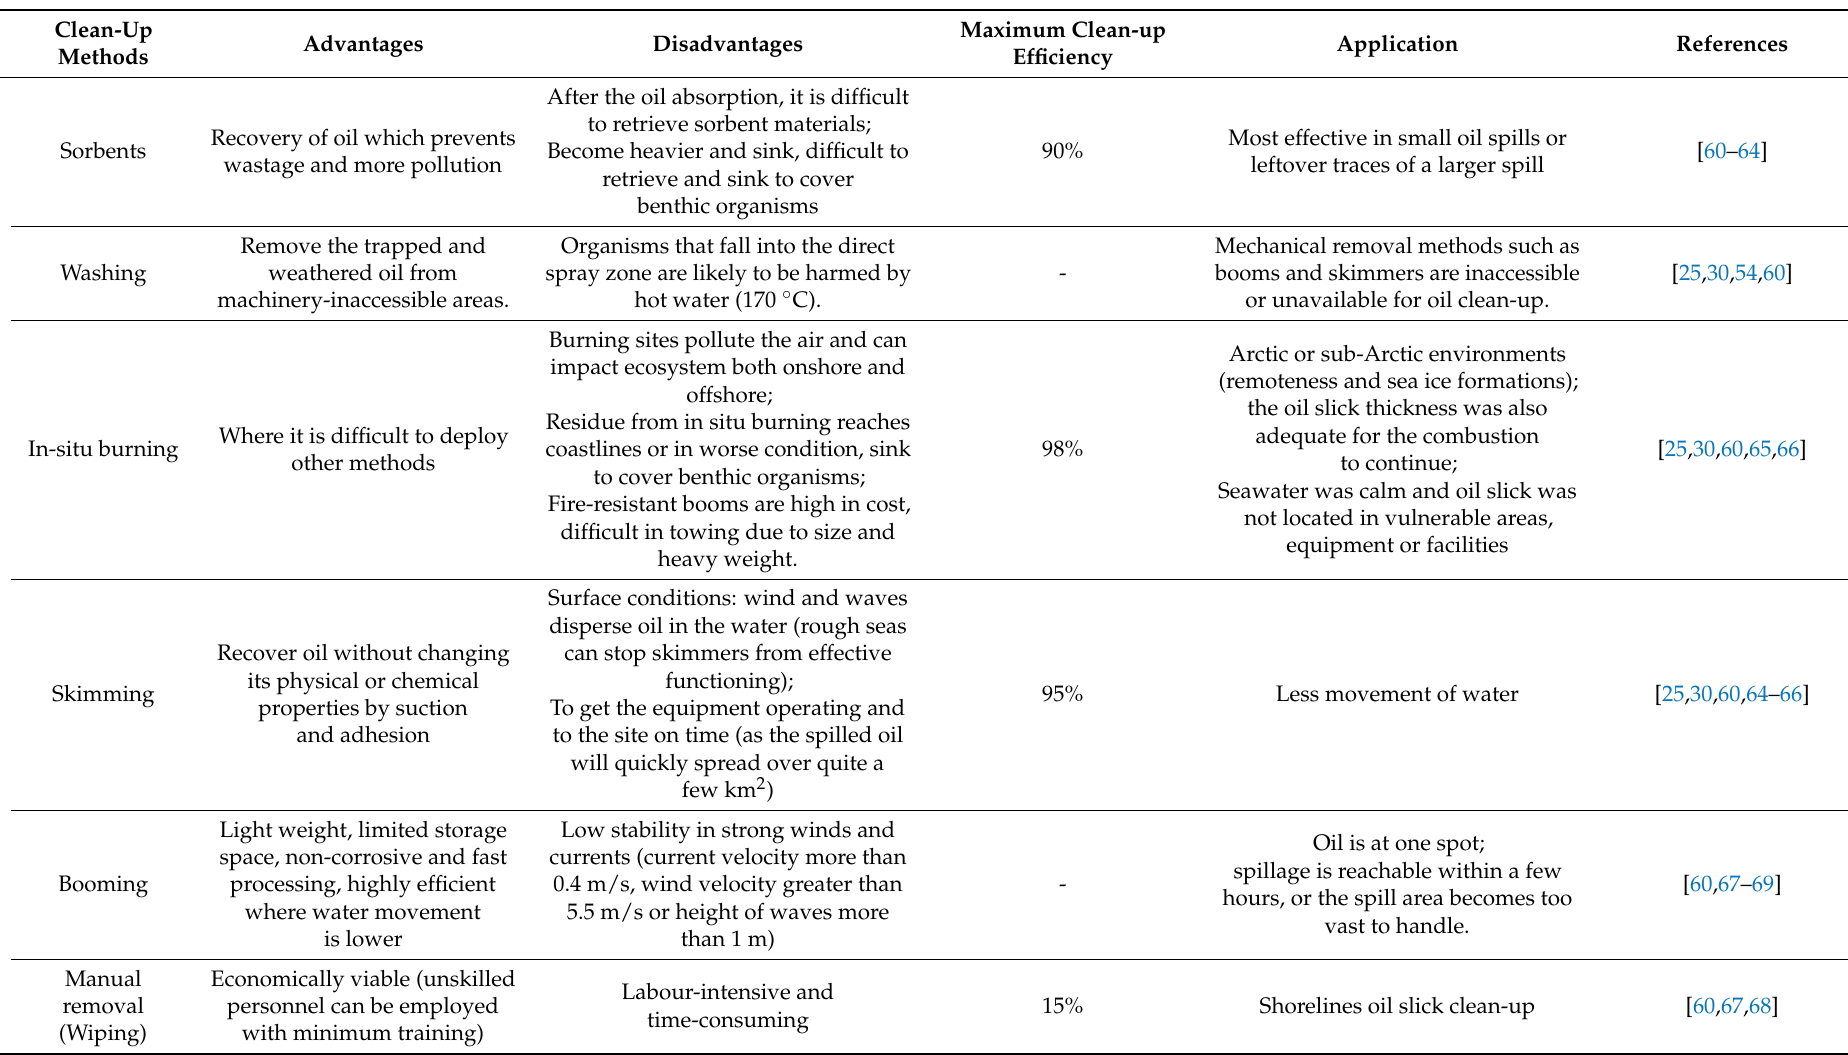
Table 2. Comparison of oil spill clean-up